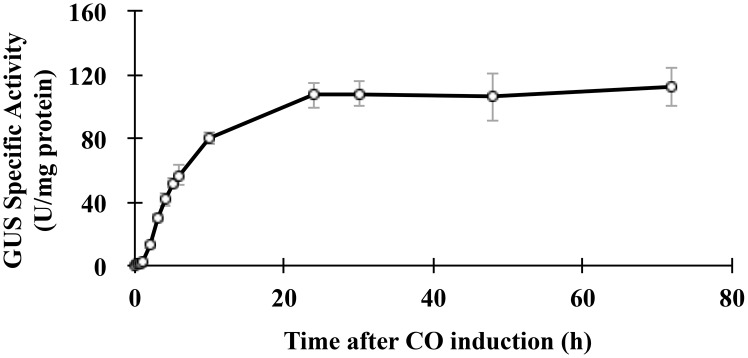
Induction of GUS-expression by carbon monoxide from an integrated PCooF−GUS-TCooF locus.Data represent average from triplicate biological samples, and error bars indicate the standard error.